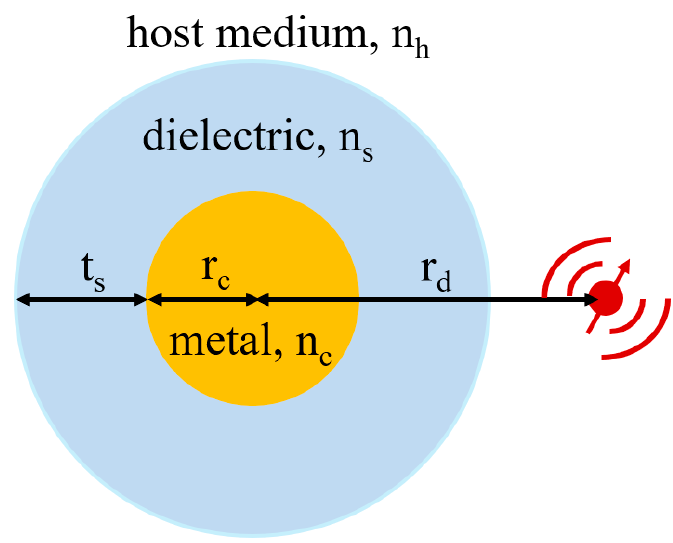
Figure 30. Emission process with dipole radiation. Adapted from Ref. [121].